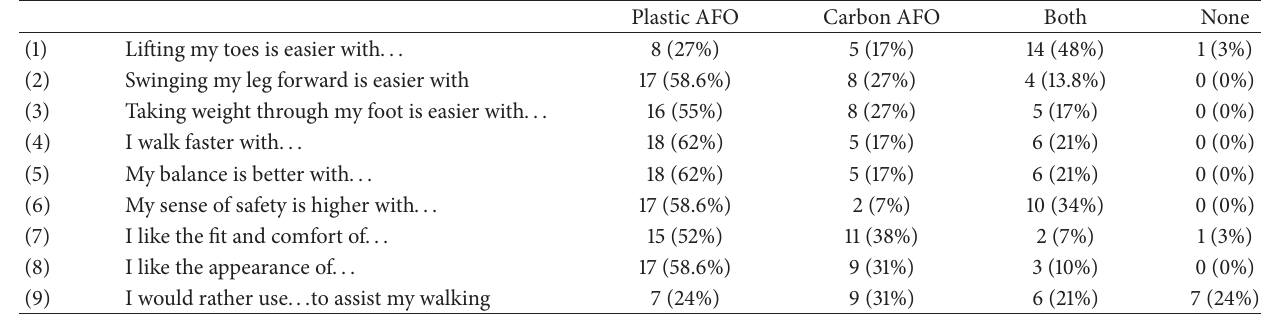
Table 2: Subjects perceptions regarding the AFO type, 𝑁 = 29